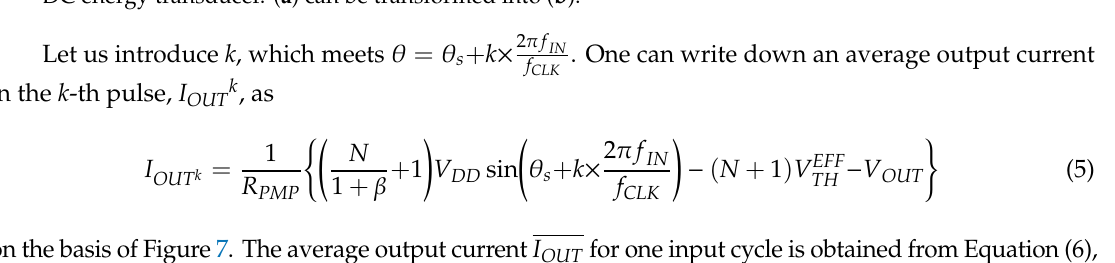
Figure 7. Equivalent circuit for the system including AC energy transducer and CP based on [15] for DC energy transducer. ( a ) can be transformed into ( b ).